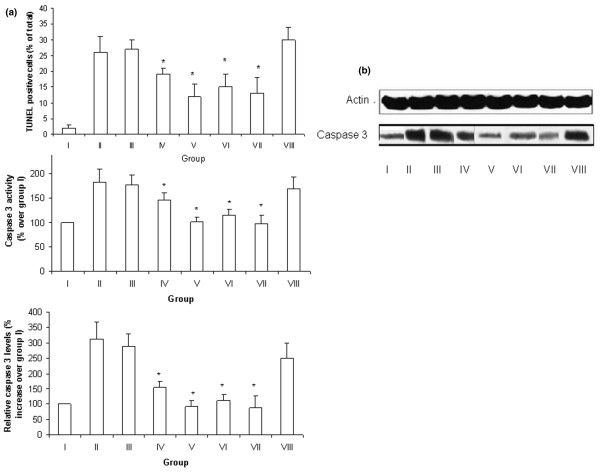
Parameters of apoptosis. (a) TdT-mediated dUTP nick end labeling (TUNEL)-positive cells (upper panel), changes in caspase 3 activity (middle panel), and changes in activated caspase 3 expression as analyzed by Western blotting (lower panel) in the left lower lobe of the different groups. Values are expressed as means ± standard error of the mean (n = 5–6 cats/group). (b) Representative Western blot analysis of caspase 3. The groups were as follows: i = nonischemic group; ii = ischemia/reperfusion; iii, iv and v = IB-MECA 50 μg/kg, 100 μg/kg and 300 μg/kg, respectively, administered 1 hour before reperfusion; vi and vii = MRS3558 50 μg/kg and 100 μg/kg, respectively, administered before reperfusion; and viii = MRS1191 pretreatment before MRS3558 (100 μg/kg) and beginning of reperfusion. *P < 0.05 versus the other groups (i, ii, iii, and viii).